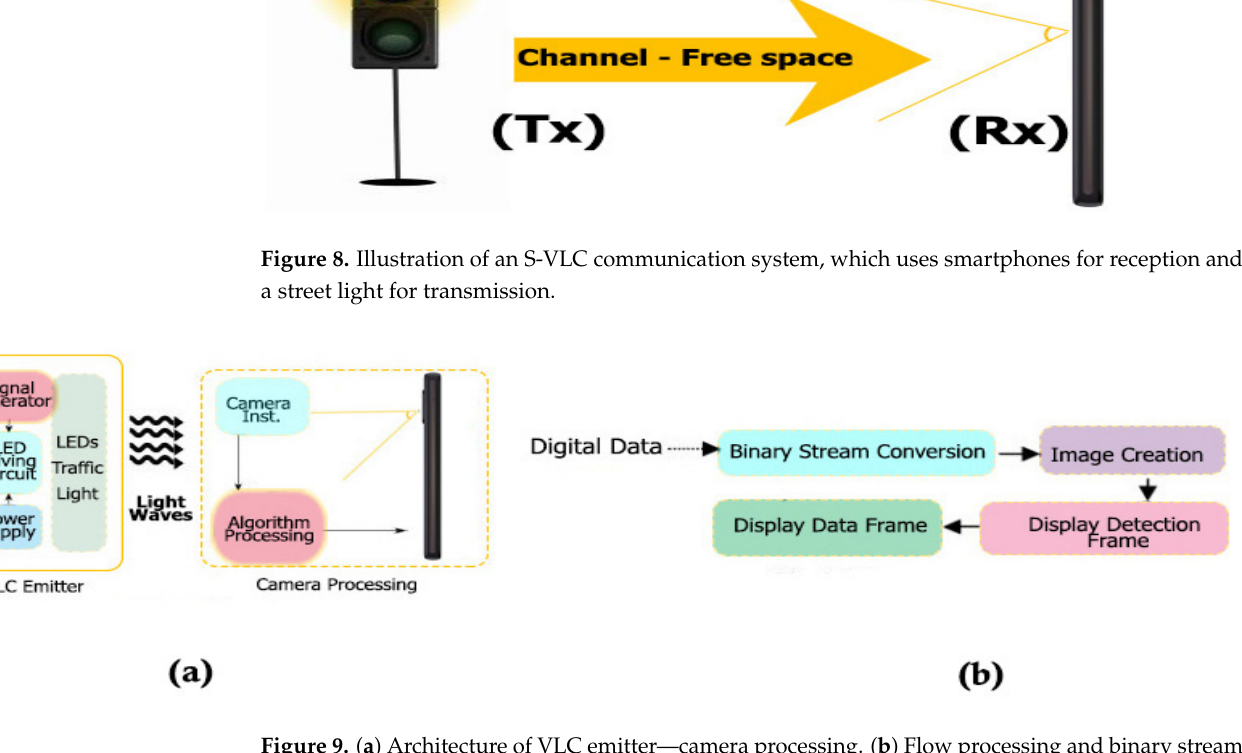
Figure 9. ( a ) Architecture of VLC emitter—camera processing. ( b ) Flow processing and binary stream conversion for frame detection.